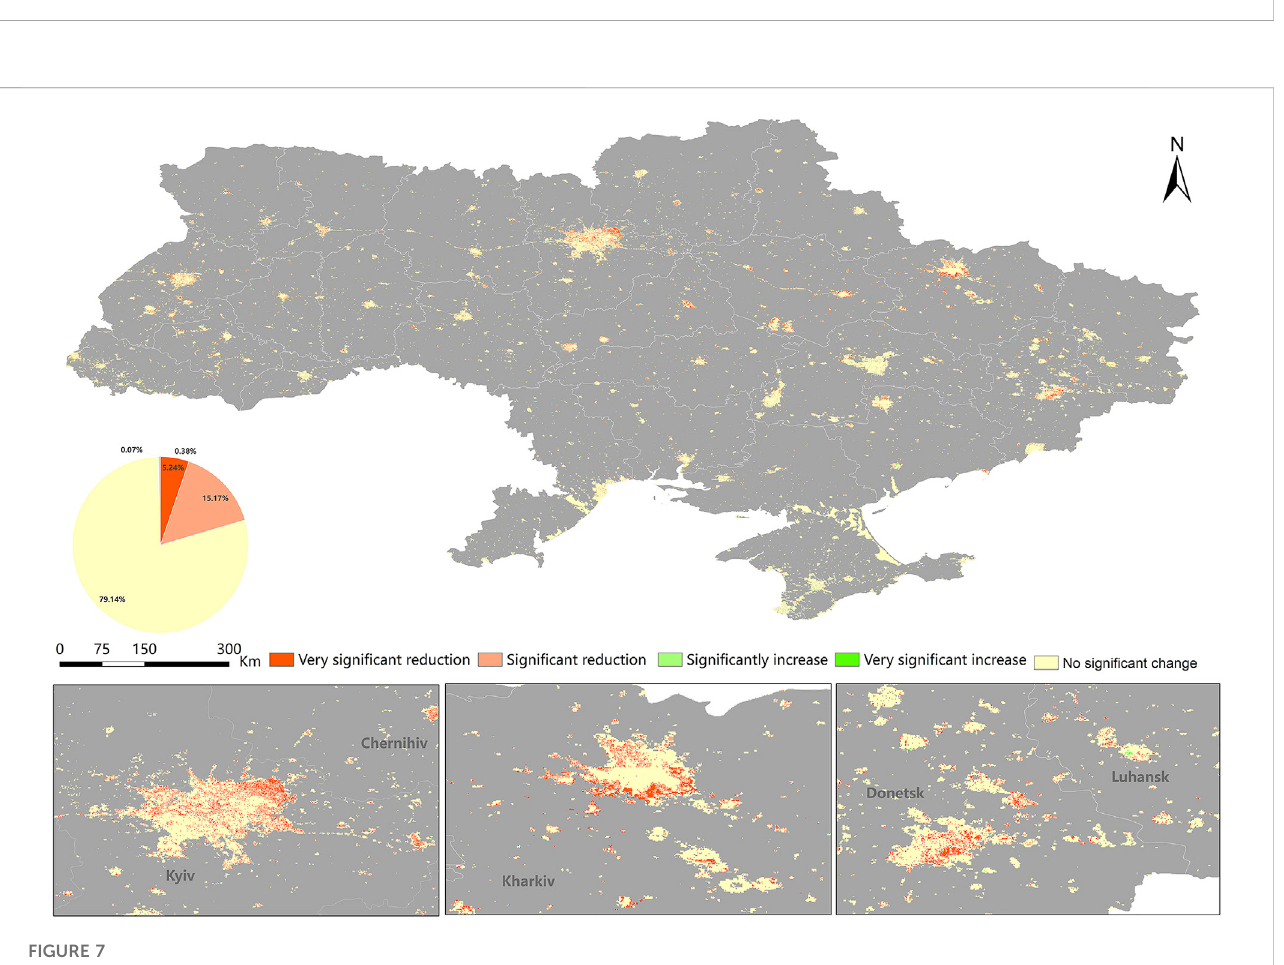
FIGURE 6 Comparison of the nighttime light DN value and area change from 2012 to 2021 (A) and from February 24 to 2 May 2022 (B) .